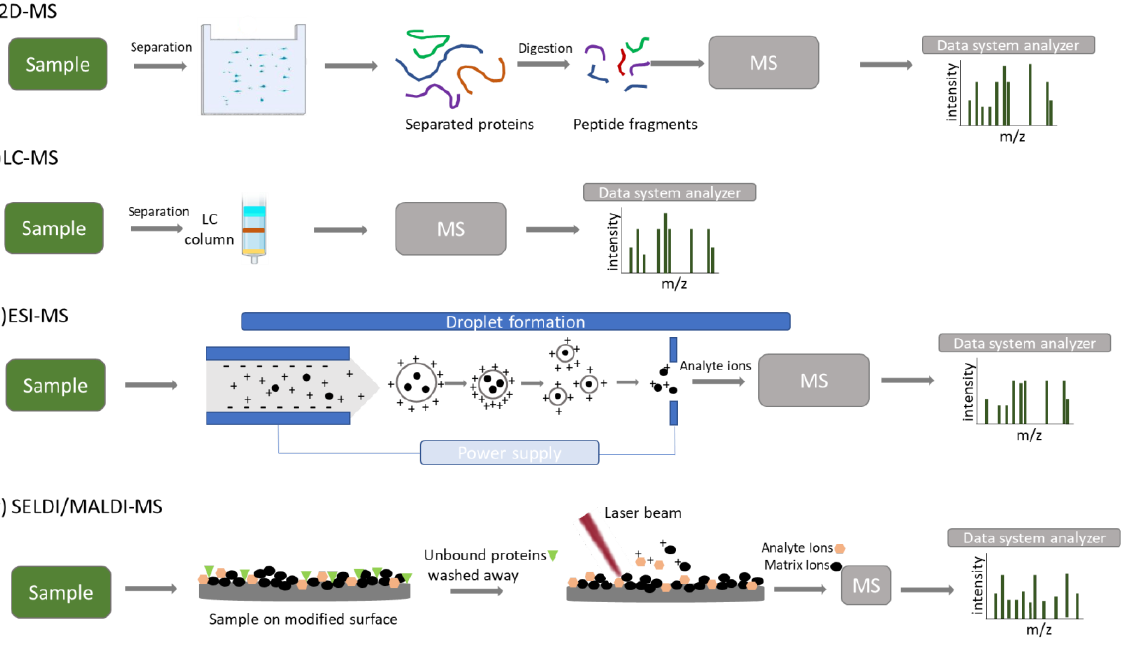
Figure 2. Schematic representation of MS techniques used in proteomics. ( i ) Two-dimensional gel electrophoresis mass spectrometry (2-DE-MS). The sample is separated using gel electrophoresis followed by digestion of proteins and mass spectrometry analysis. ( ii ) Liquid chromatography mass spectrometry (LC-MS). The sample is separated using liquid chromatography followed by ionization and mass spectrometry analysis. ( iii ) Electrospray ionization mass spectrometry (ESI- MS). High voltage is applied to the liquid sample to produce ions (electrospray) and assist the transfer of ions from the solution into the gaseous phase. The resulting charged ions are driven for mass spectrometry analysis. ( iv ) Surface-enhanced laser desorption/ionization / matrix-assisted laser desorption/ionization mass spectrometry (SELDI/MALDI-MS). The sample is applied to a modified surface and contaminants and unbound proteins are washed away (SELDI). A pulsed laser is used to irradiate the sample which is cocrystallized with matrix, resulting in the sample and matrix's ablation and desorption. Analyte ions are driven for mass spectrometry analysis. There are two main strategies through which the proteome analysis is conducted, the bottom-up and the top-down [31]. Through the bottom-up method, MS allows conclu- sions to be drawn about the proteins in the undigested sample. It is common practice to identify proteins and determine their sequence and post- translational modifications using the bottom-up method [32]. Using this method, target proteins are subject to enzymatic, proteolytic digestion from which protein fragments are derived and examined using ESI or MALDI. These mass spectrometry methods enable the gas phase transfer of peptide and protein molecule ions without fragmentation. There are two steps to the ESI – or MALDI – mass spectrometry analysis. The determination of the masses of the intact peptides takes place at the first step, and then the sequence and mod- ifications of these peptide ions are revealed by fragmenting them in the gas phase [31]. The top-down technique determines the protein ’ s molecular mass when intact pro- tein ions are introduced into the gas phase, fragmented, and examined in a mass spec- trometer. This method can thoroughly describe the protein ’ s fundamental structure, re- veal its modifications, and disclose any relationships between these modifications if enough informative fragment ions are observed [33]. In any case, for the analysis of the samples to take place, it is necessary to precede protein purification with techniques such as LC, native and denaturing one-dimensional (1-D) and two-dimensional (2-D) gel elec-